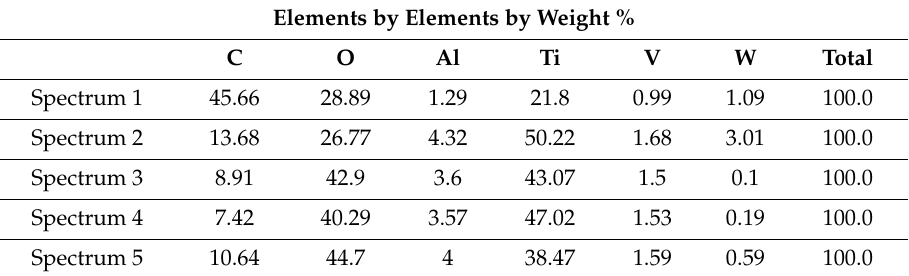
Figure 14. The e ff ect of machining technique on the cutting edge rounding at N = 37.68 m / min and f = 0.075 mm / rev for ( a ) VAD A m = 0.25 mm and ( b ) CD. Table 1. Energy-dispersive X-ray spectroscopy (EDS) element composition analysis for the selected points in Figure 11.